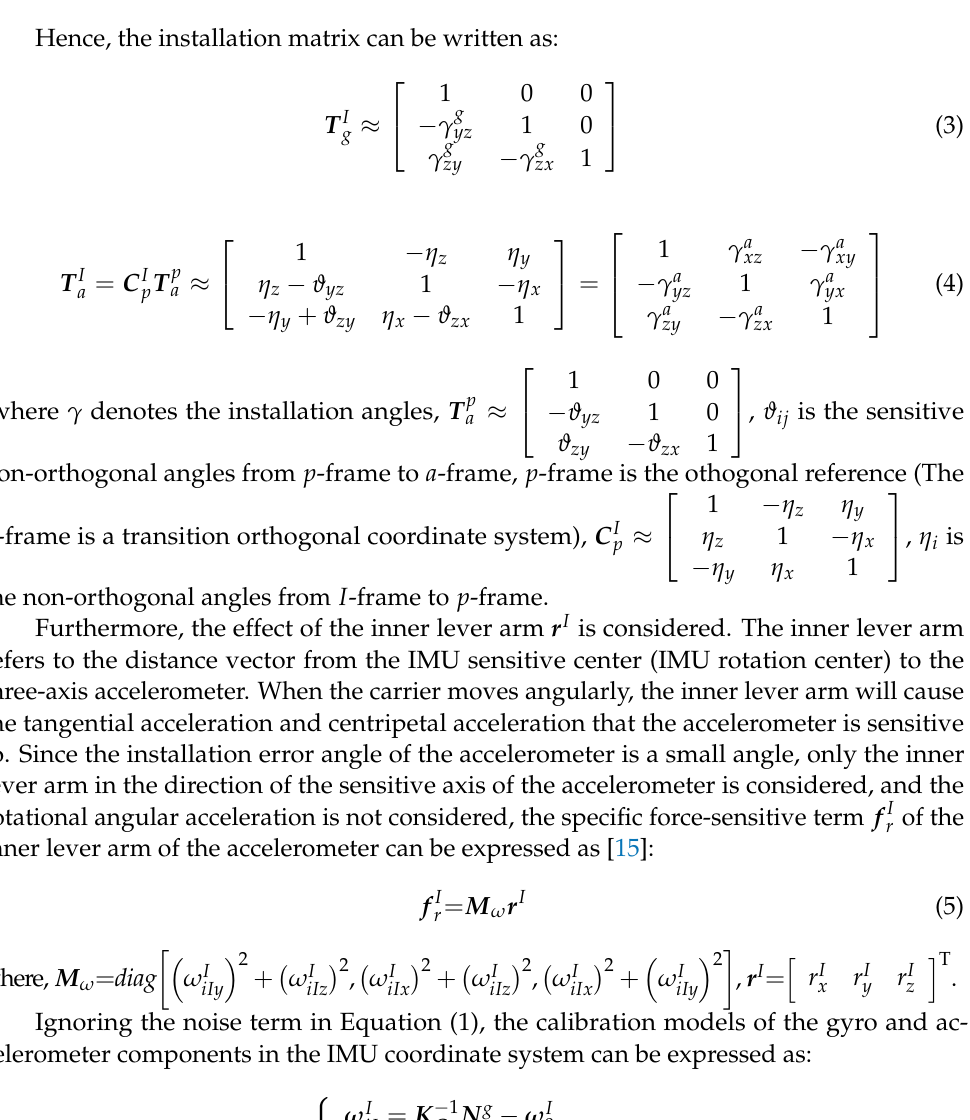
Figure 1. The conversion relationship between the non-orthogonal coordinate frame of the gyro and the orthogonal coordinate frame of the